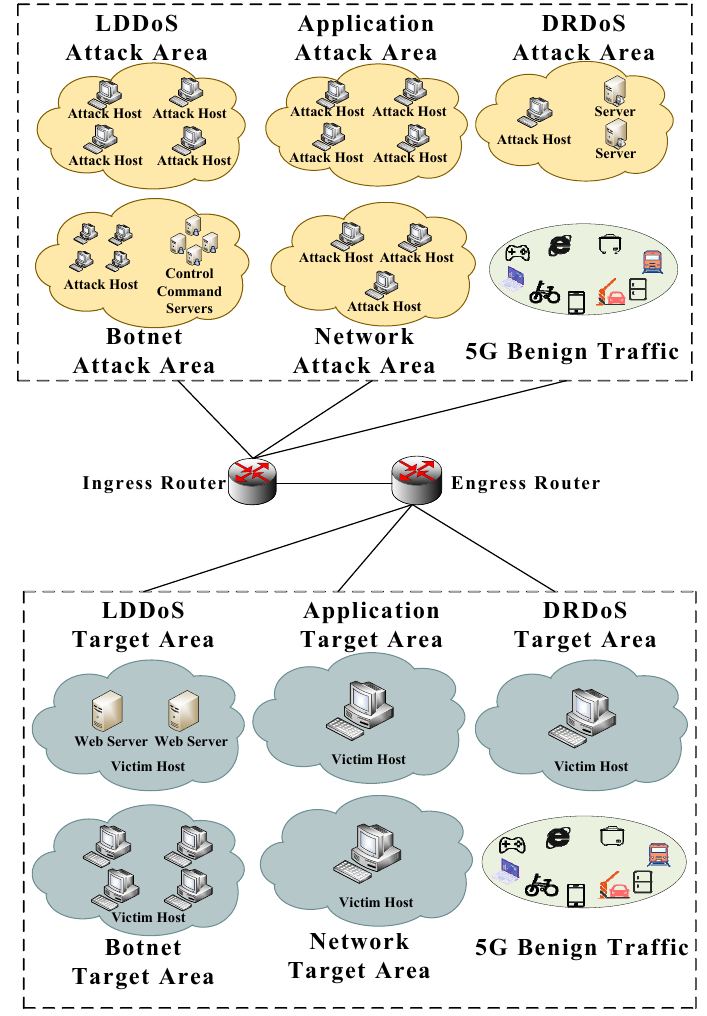
Figure 3. Network topology diagram.